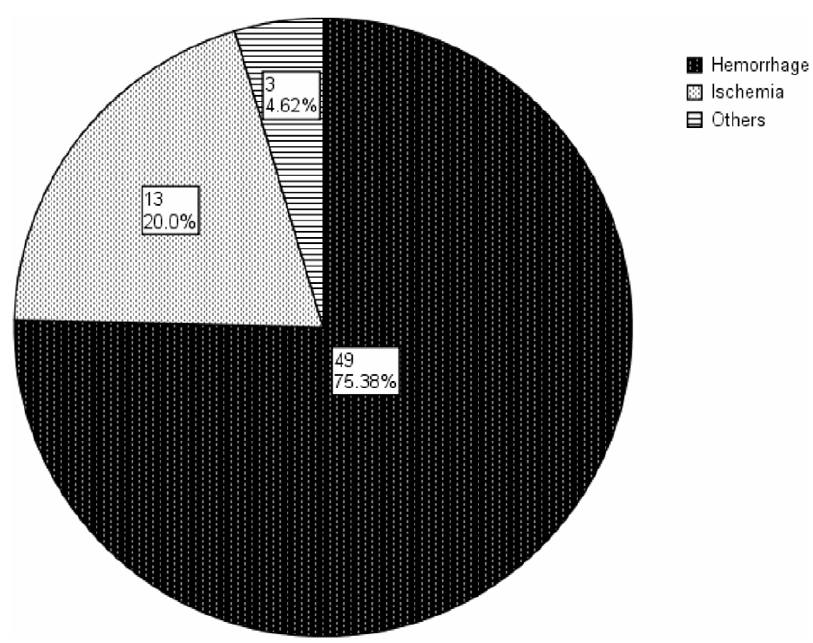
Figure 1. Disease pattern of MMD in Chaoshan District. doi:10.1371/journal.pone.0036386.g001 (Table 2). The age distribution was bimodal in all areas, including Asian countries. Positive family history was frequently found in patients from Asian countries.